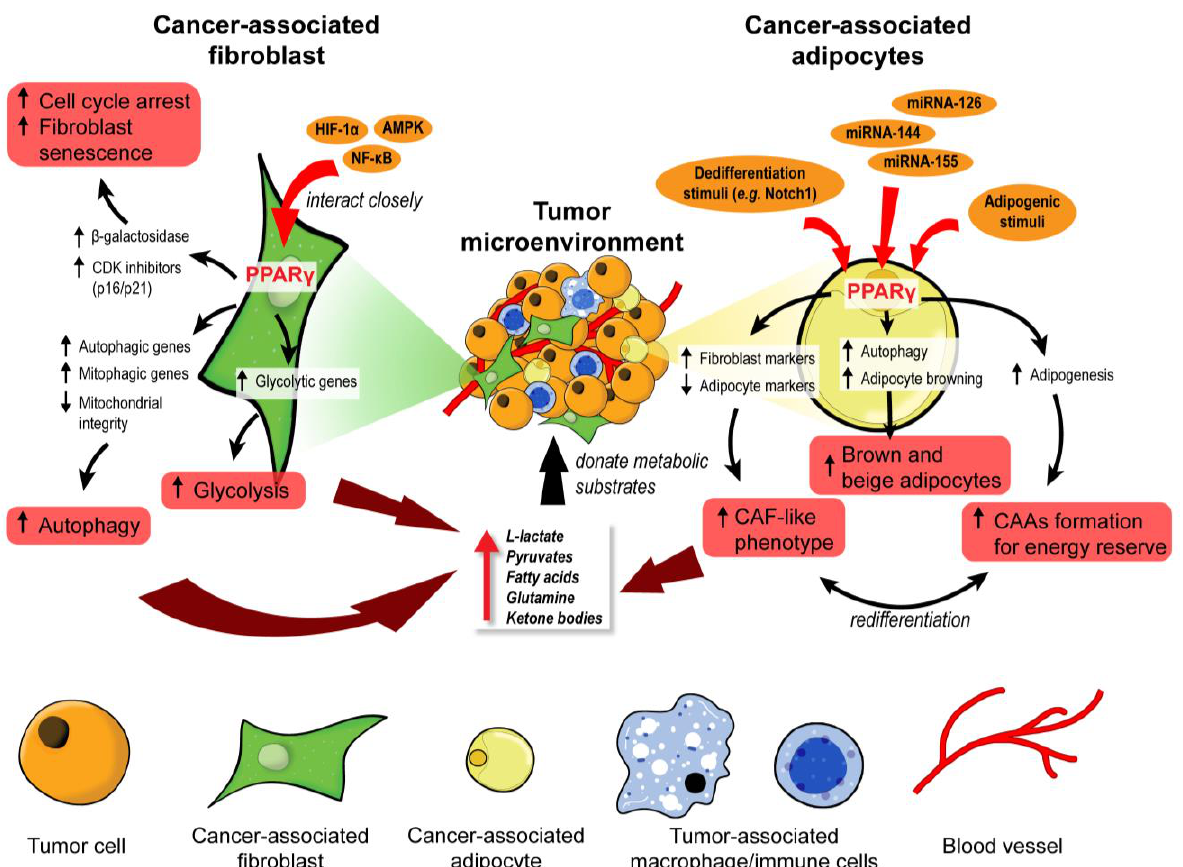
Figure 2. PPAR γ orchestrates the metabolic reprogramming of cancer-associated fibroblasts and adipocytes. In cancer-associated fibroblasts (CAFs), PPAR γ interacts closely with HIF-1 α , AMPK, and NF- κ B to promote cell cycle arrest, senescence, autophagy, and glycolysis. These functional changes unleash many metabolic substrates into the tumor microenvironment for the neighboring tumor cells. Similarly, PPAR γ governs the fate and function of cancer-associated adipocytes (CAAs). Upon exposure to adipogenic stimuli, PPAR γ mediates adipogenesis and formation of CAAs to act as an energy reserve. In contrast, exposure to dedifferentiation stimuli drives CAAs to adopt a CAF-like phenotype and act as a substrate doner in the tumor microenvironment. Certain miRNAs can suppress PPARγ to induce brown and beige differentiation of CAAs which are also energy donors for cancer progression.